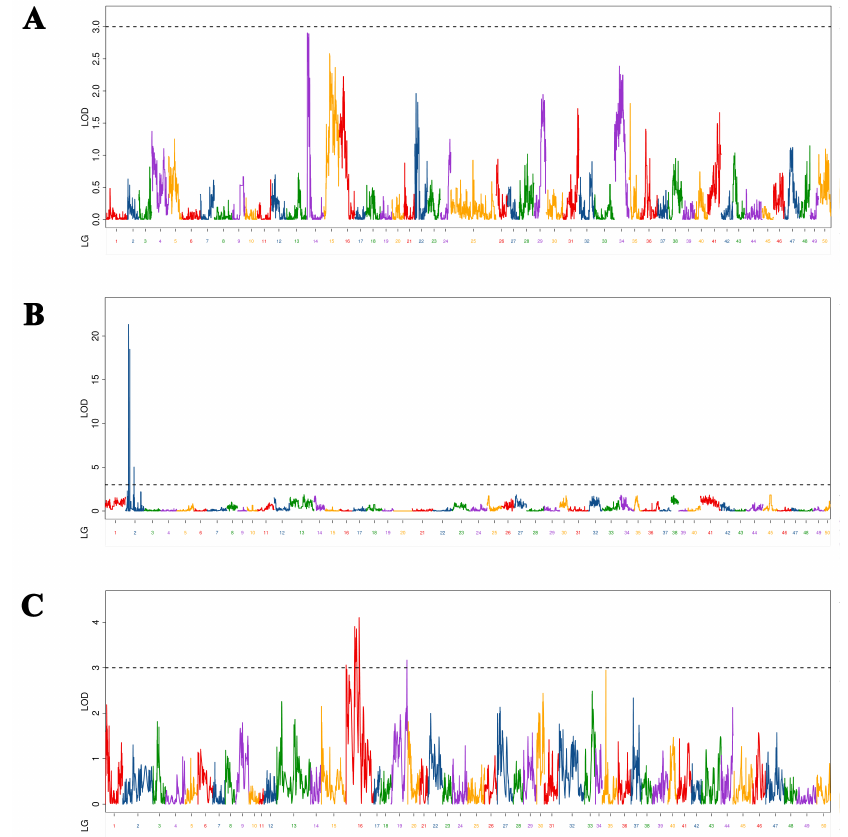
Figure 1. Distribution of body length-related QTLs on 50 linkage groups of Yellow River carp in the maternal ( A ), paternal ( B ), and HH maps ( C ). Different color indicates different linkage group.